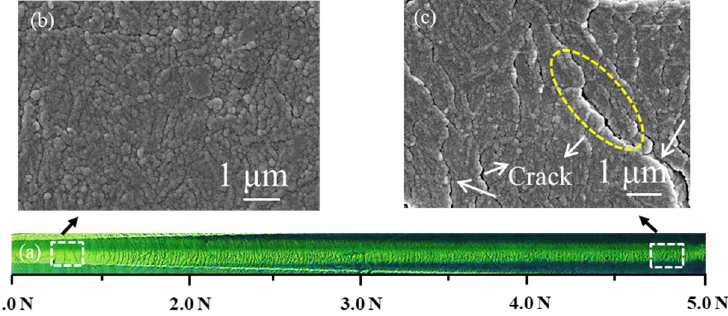
Figure 10. The scratch morphology of the UHMWPE substrate treated with carbon plasma of 1.0 A: ( a ) optical morphology; ( b , c ) surface morphologies of different positions.